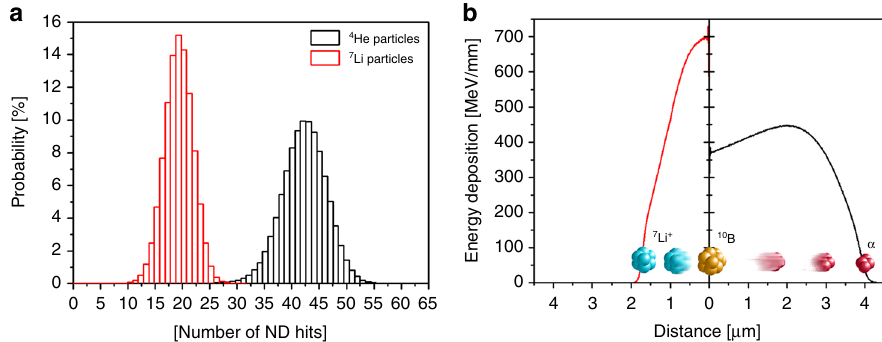
Fig. 2 Interaction probability and energy deposition of α and 7 Li + particles. Compared to 7 Li + particles, α particles can interact with a higher number of nanodiamond (ND) particles and deposit energy over a larger distance in 33 weight % dispersion of 35-nm spherical NDs in 10 B 2 O 3 . a Probability of the number of ND hits per one α particle and 7 Li + ion generated using reaction (1) and b energy deposition of these α particles (black) and 7 Li + ions (red) along their trajectory. On average, a single α particle with an energy of 1.47 MeV interacts along its ~3.9 μ m trajectory with 42 nanoparticles before losing its kinetic energy. Similarly, a 0.84 MeV 7 Li + ion interacts along its ~1.7 μ m trajectory with another 19 nanoparticles. The histograms and energy depositions were calculated from simulation of trajectories performed with the Geant4